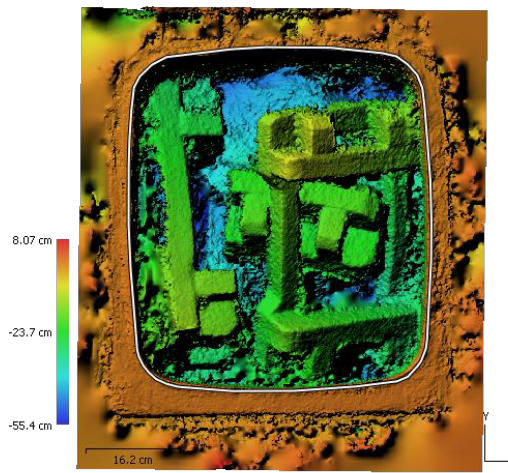
Figure 10: DSM example from a waste bin, derived from 16 images, filled approximately ¾ of the max. bin